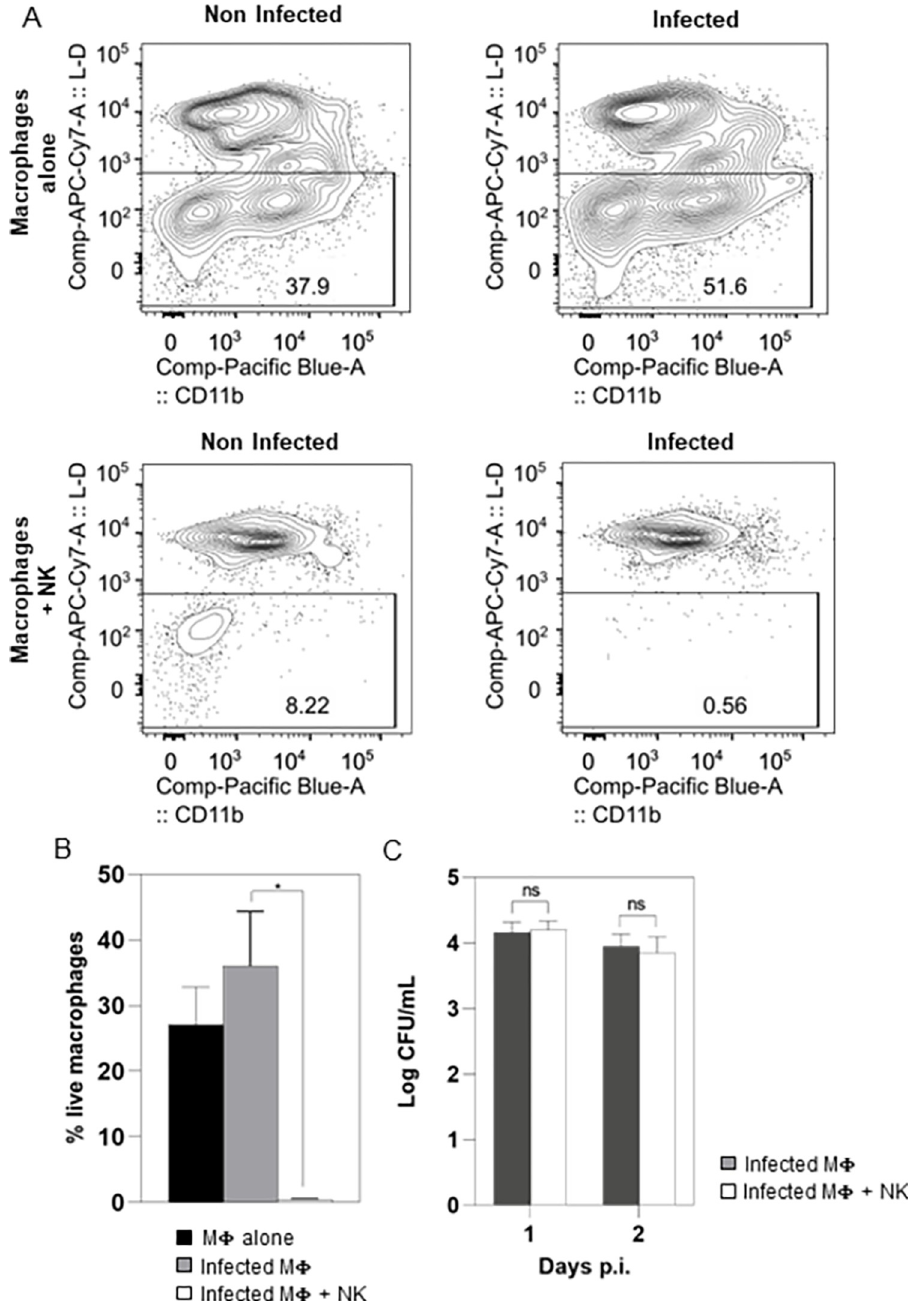
Fig 7. Intracellular M . abscessus survives the killing of infected macrophages by NK cells. (A-B) Splenic CD11b + macrophages were isolated from na ï ve mice. Macrophages were either infected or not with M . abscessus . Then, autologous splenic NK cells were either added or not to the culture. (A) Cells were labelled with live dead staining followed by anti-NK1.1 and CD11b antibody staining. The plots represent the survival of macrophages (NK1.1 - cells) that were not infected or 2 days after M . abscessus infection in the presence or absence of NK cells. (B) Mean survival of macrophages not infected (black bar) or infected with M . abscessus in the absence (grey bar) or in presence (white bar) of NK cells analyzed by flow cytometry. (C) Intracellular M . abscessus quantification on day 1 and 2 p.i. by CFU (Colony Forming Unit) counting in the absence (black bar) or in presence (white bars) of NK cells (n = 3 independent experiments) Data were analyzed by Student t test (B; * p < 0.05, ns: non-significative) or two-way ANOVA test (C).